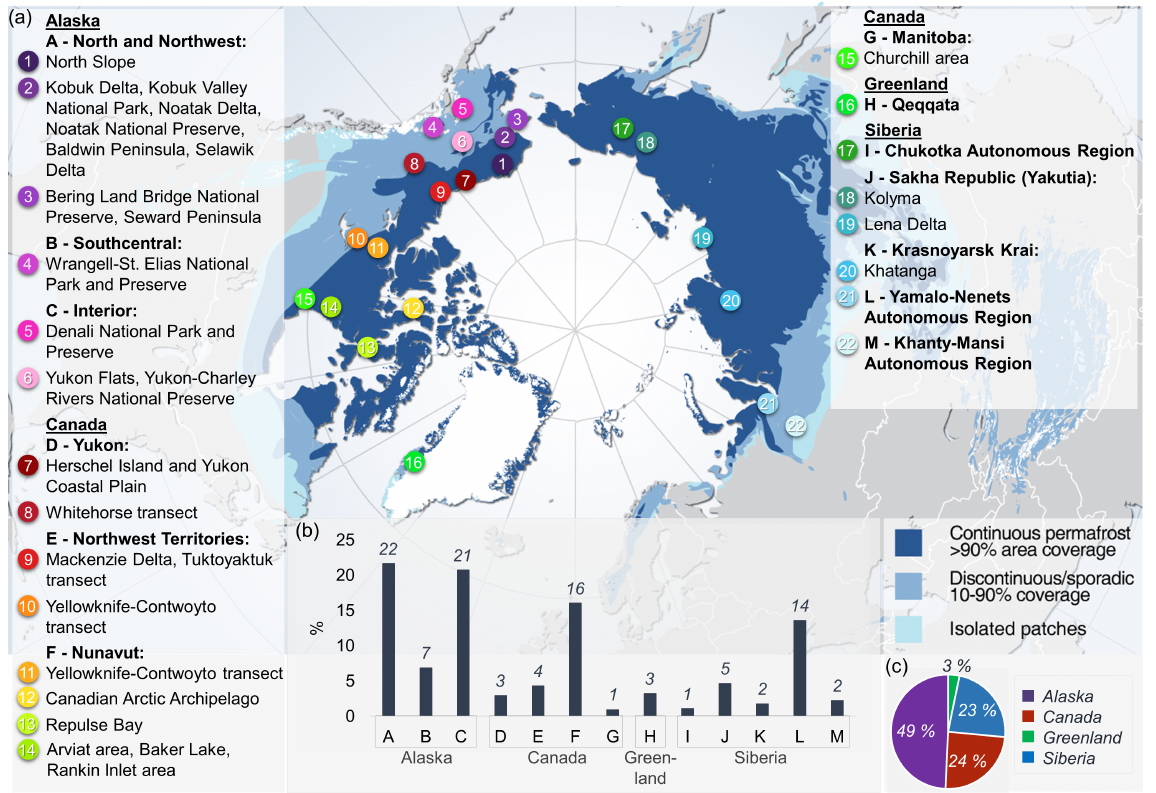
Figure 1. Overview of study regions (underlined bold font), study areas (bold font) and sites overlain on the map of permafrost zones (a) ; histogram of the amount of lakes in percentage by the study area in our dataset (b) ; and pie chart of lake distribution in the dataset by overarching regions (c) (background map after Brown et al.,